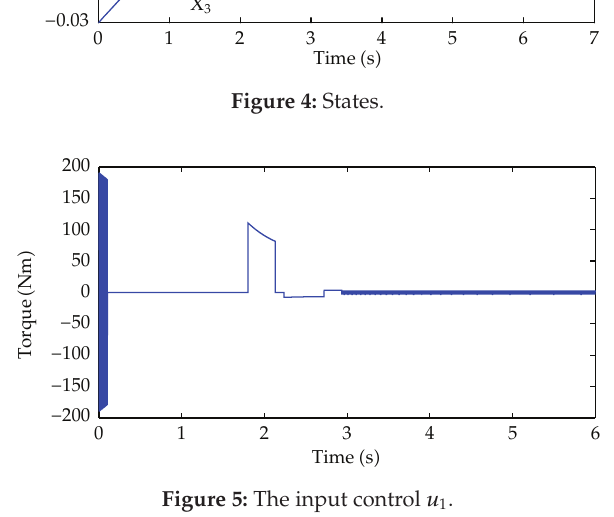
Figure 5: The input control u 1 .